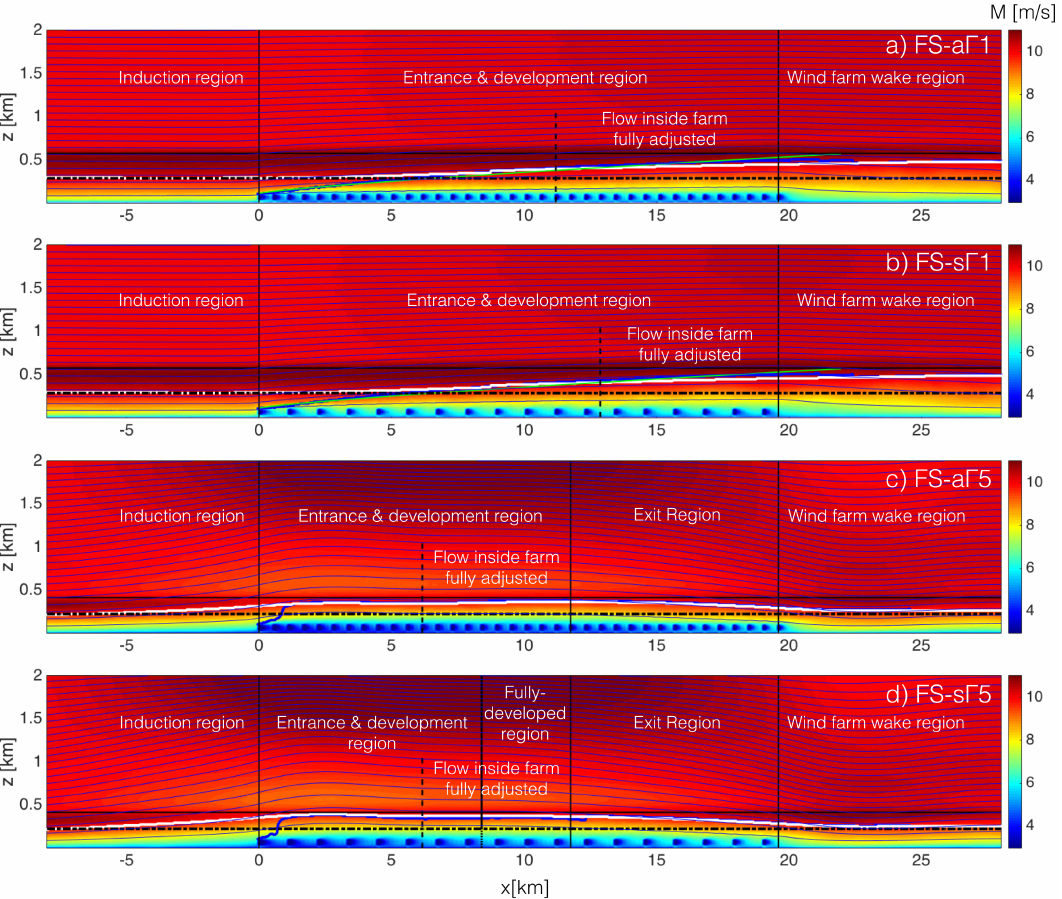
Figure 4. Contours of time-averaged horizontal velocity magnitude M on the xz plane through the center of a wind turbine column for the case ( a ) FS-a Γ 1; ( b ) FS-s Γ 1; ( c ) FS-a Γ 5; ( d ) FS-s Γ 5. The IBL height (thick blue line), the CNBL height (white line), the CNBL height of the inflow (dashed black line), Elliot’s 0.8 power law (bright green line) and the CNBL height with an infinite wind farm (solid black line) are also included. The thin blue lines are the velocity streamlines (i.e., the vertical component is made larger by a scale factor of 5). The black vertical solid lines indicate the start and end of different flow regions.